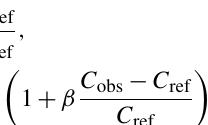
Figure 16. Average relative bias of the model against NO 2 station data, calculated for each day between 9:00 and 17:00LT, between 15 and 29 June. The blue line shows the initial run R0, and the red dashed line shows run R1 with the updated weekly cycle of emis- sions (see Fig. 17). The vertical dashed lines separate the weekends (green) and weekdays